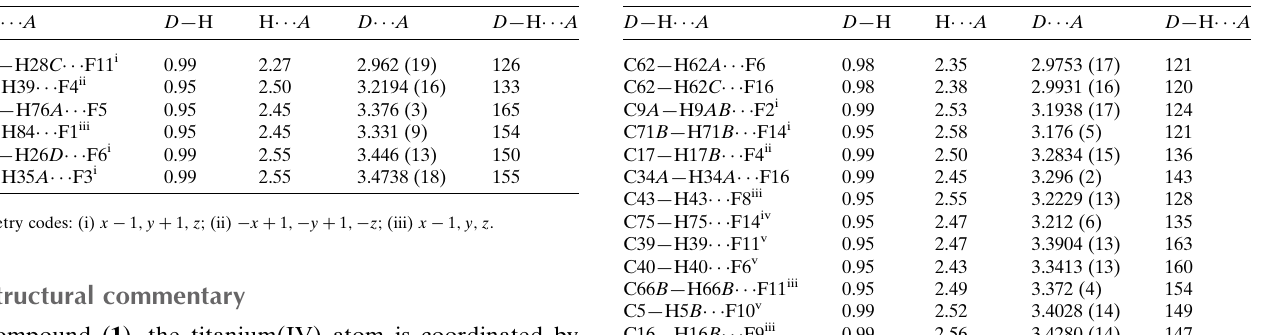
Table 2 Hydrogen-bond geometry (A˚ , (cid:4) ) for ( 2 ).